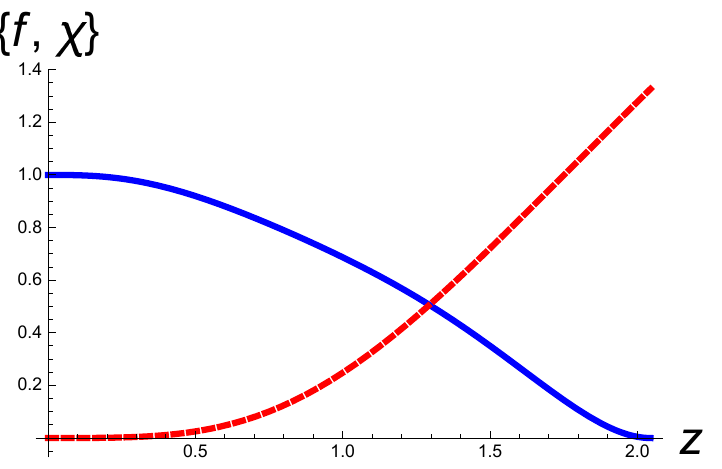
Figure 2 . The warped factor f (solid blue curve) and χ (dashed red curve) in the metric interpo- lating the horizon z = z h ’ 2 . 044 to the AdS boundary z = 0 for a = 6 / 5 , m = 2 / φ 0 = 1 , and C = 0 .